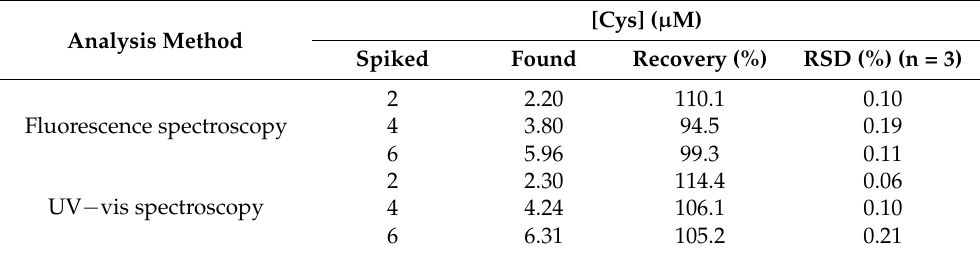
Table 1. Results of spiking test for Cys detection in human serum using A-B . Analysis Method